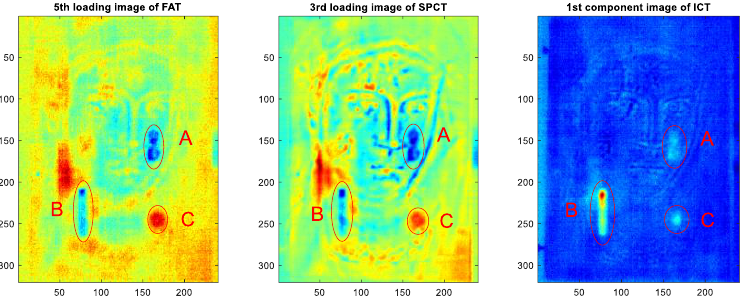
Figure 4. Thermographic data analysis results obtained in Madonna panel painting. The authors made these illustrative figures specifically for this manuscript based on the existing dataset and methods proposed in Refs. [4,55]. methods proposed in Refs.